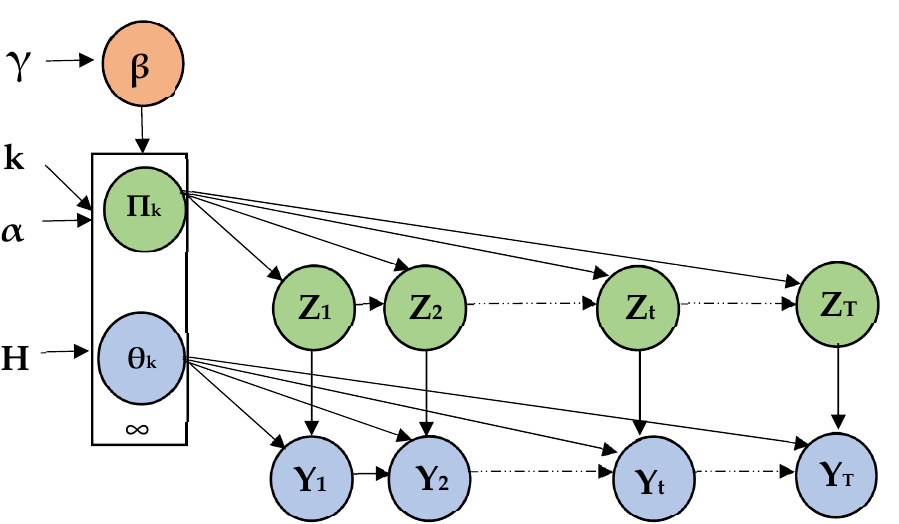
Figure 3. State-space diagram representative of the sticky HDP-HMM with DRP prior and state- specific transition distributions.